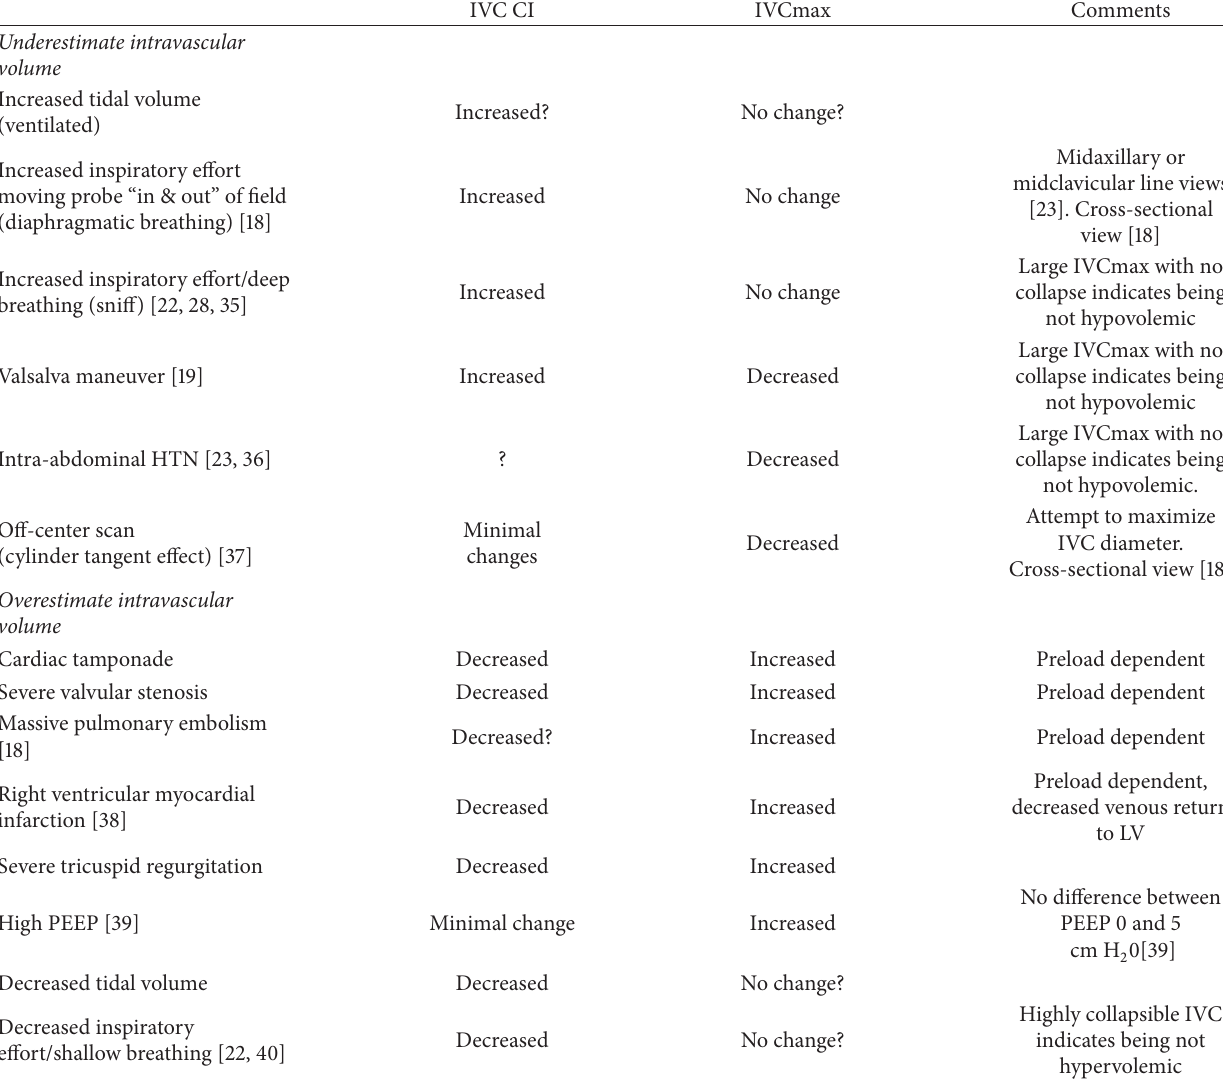
Table 2: Conditions biasing inferior vena cava ultrasound